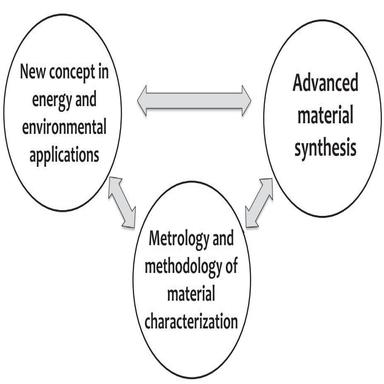
Three important aspects of implementing the functional nanostructured material for energy and environmental applications.